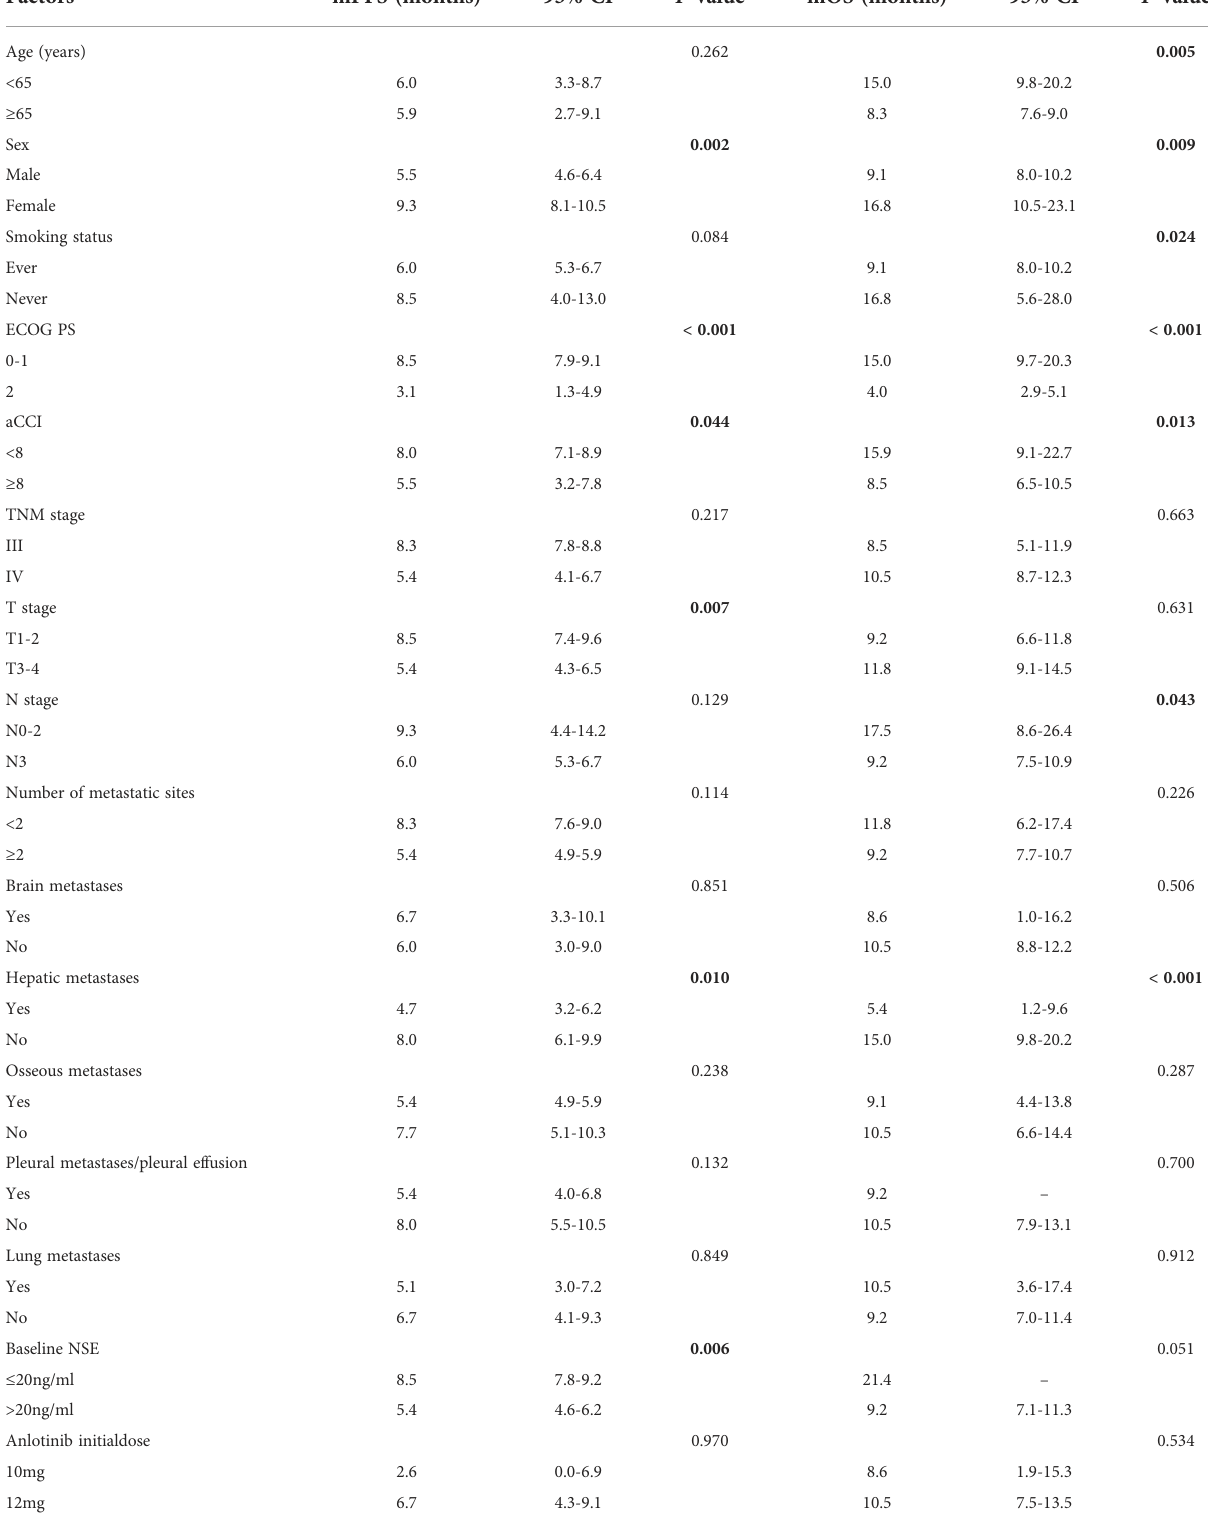
TABLE 2 Univariate analysis of factors associated with PFS and